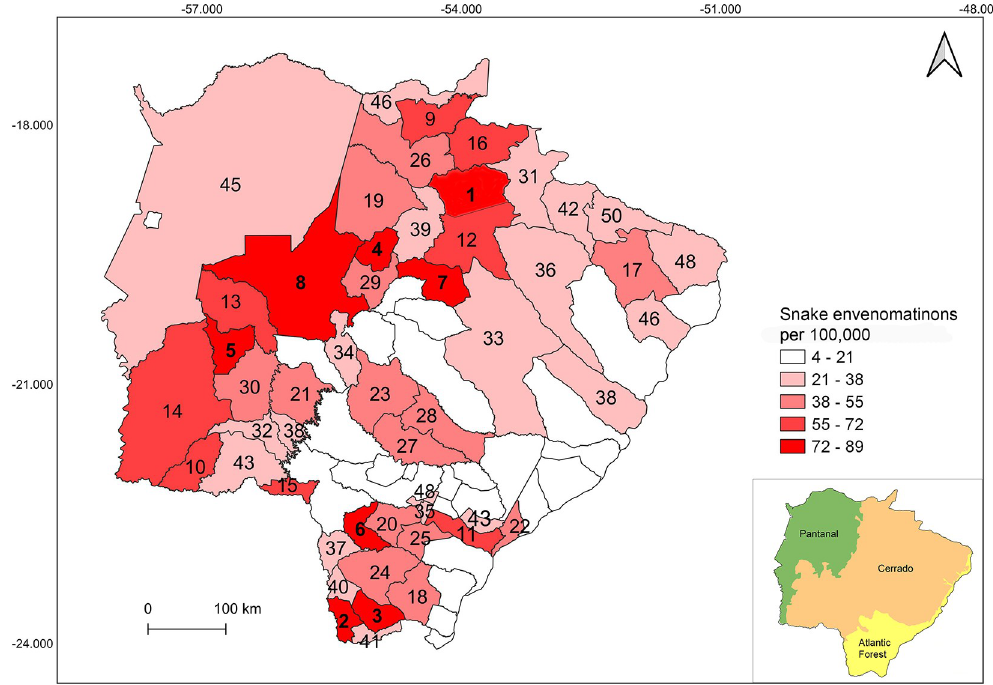
Fig 4. The mean number of snake envenomation per 100,000 population for municipalities between 2008–2009 and 2011–2017 in Mato Grosso do Sul state (Brazil). Municipalities codes are listed in S1 Table. IBGE—All maps are in the public domain.